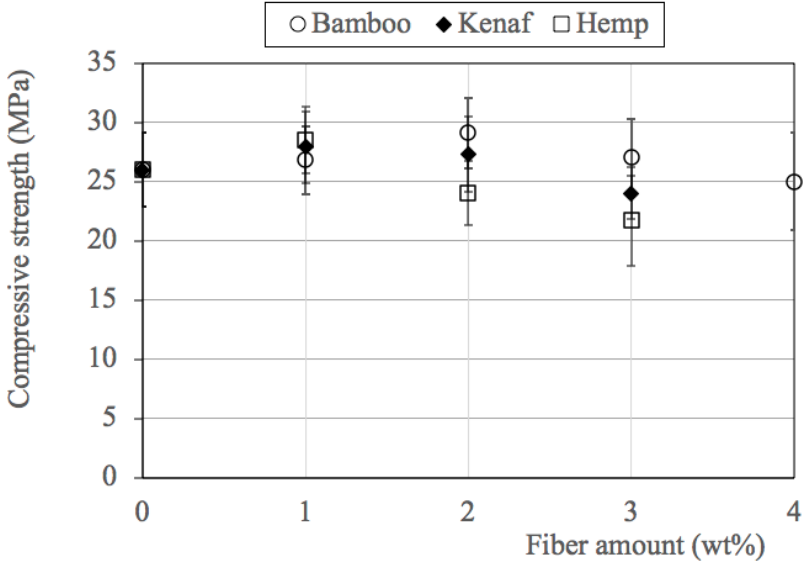
Figure 8. Absorbed energy for the different composites during the flexural test.